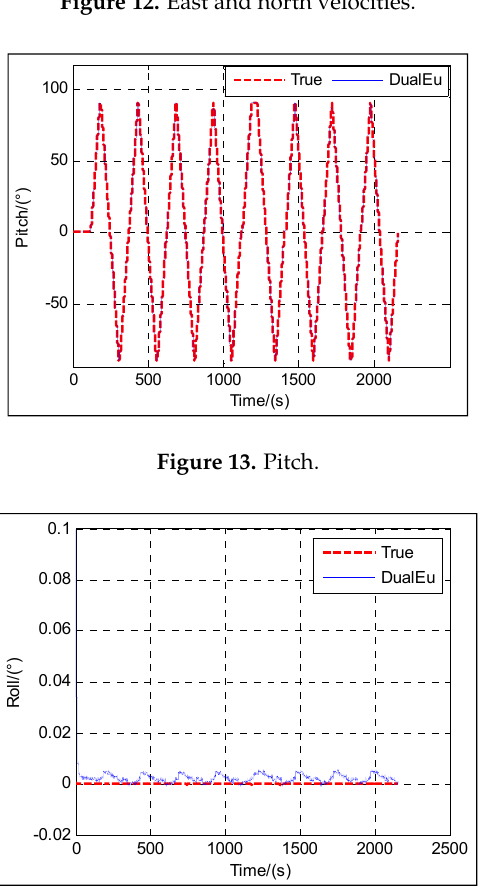
Figure 14. Roll. Figure 14. Roll.